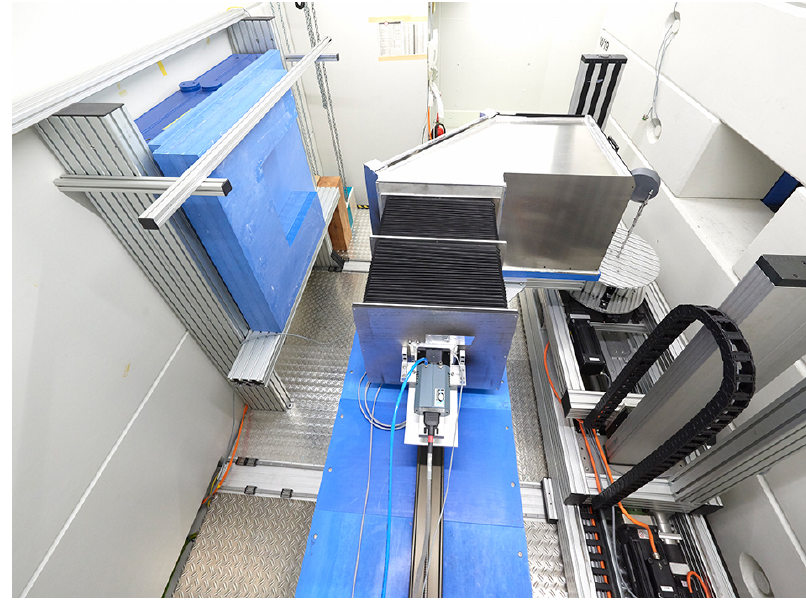
Figure 1: Instrument NECTAR: The fission neutrons are coming from the right, penetrating the sample fixed on the manipulator, and are detected by a CCD-based system (center). A beamstop (left) minimizes scattered radiation. (Copyright by W. Schürmann,